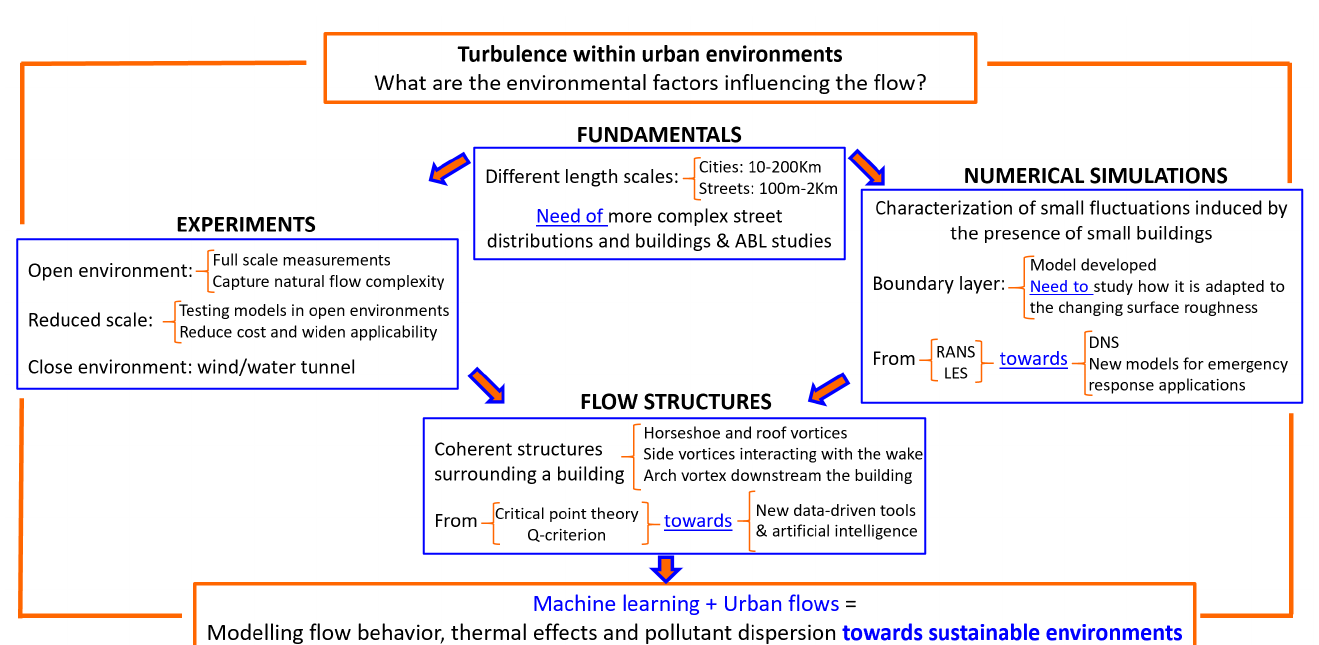
Figure 1. Summary of the main research lines and future tendencies discussed in this